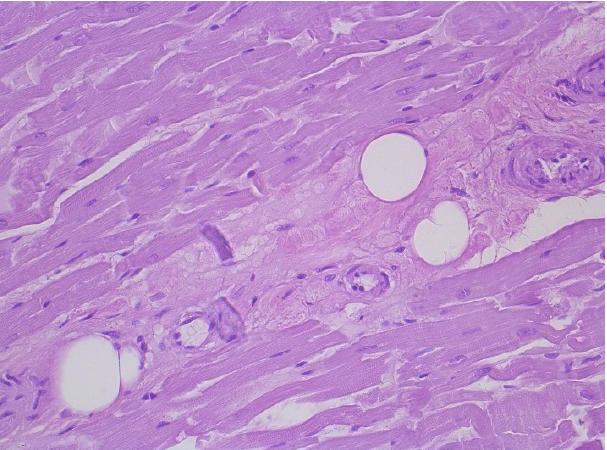
Fig. 5. Myocardium. The stroma of the organ is loosened, impregnated with a transudate rich in glycoproteins.